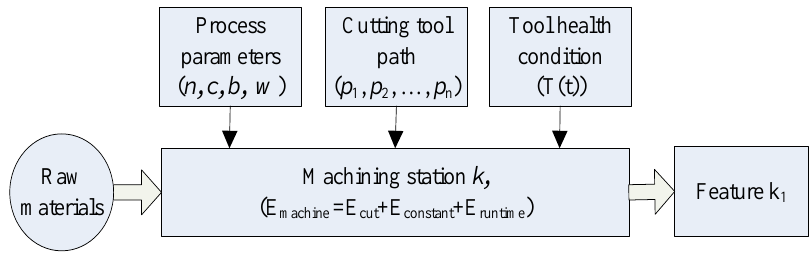
Figure 3. Illustration of energy consumption for feature operation at process level.